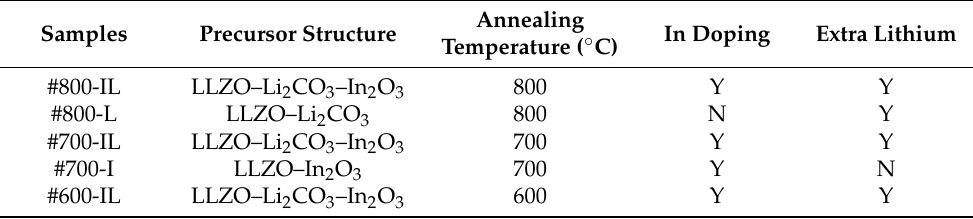
Figure 1. The preparation process of the In-doped LLZO–LZO thin film, which contains sequential and repeated deposition of the LLZO, Li 2 CO 3 , and In 2 O 3 thin film and heat-treatment at various temperatures. Table 1. Samples of LLZO–LZO thin film solid electrolyte and their preparation